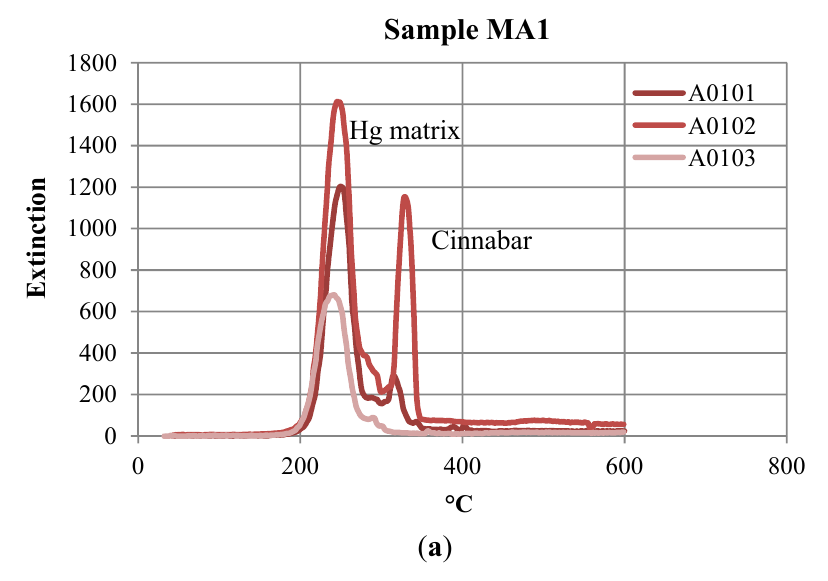
Figure 5. Hg-thermodesorption curves (Hg-TDC) of samples: ( a ) MA1 (mining wastes); ( b ) MA2 (mining wastes); ( c ) MA3 (contaminated soil); ( d ) MA4 (calcine); ( e ) MA5 (calcine); ( f ) MA6 (mining wastes); and ( g ) MA7 (calcine).